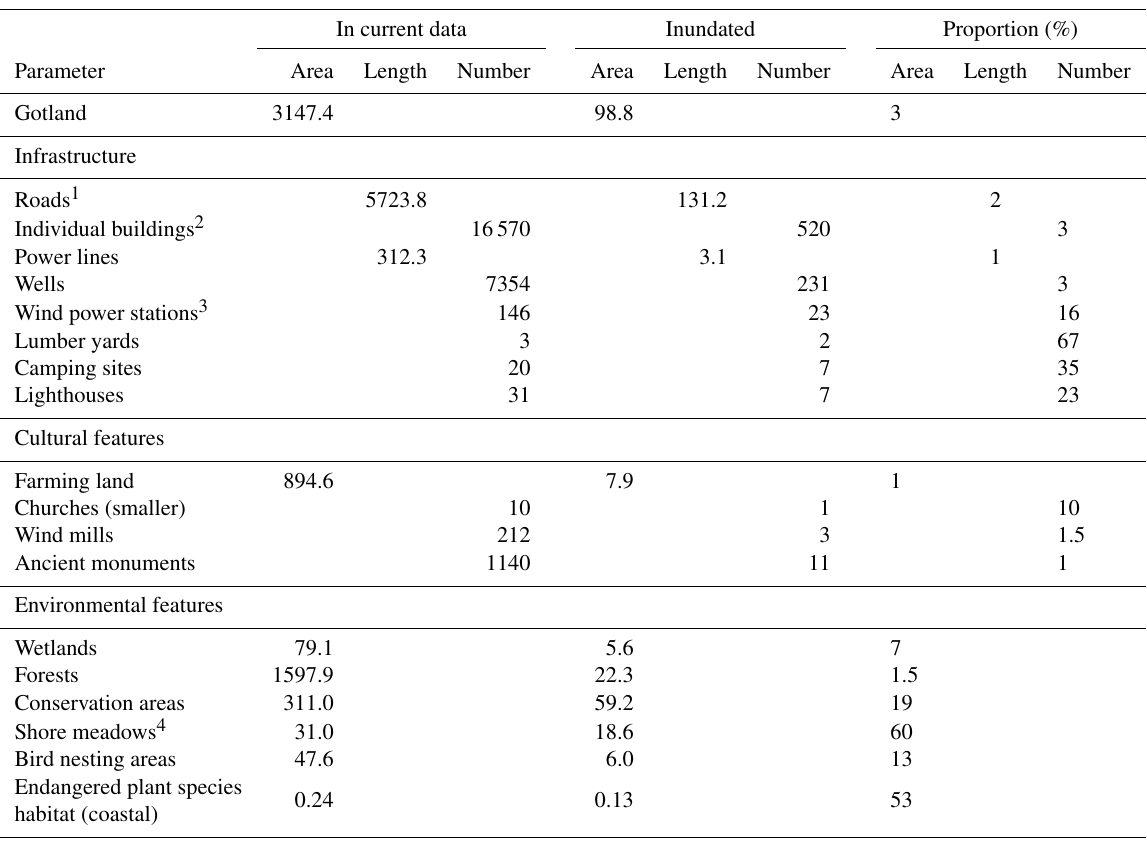
Table 2. Proportions of various types of infrastructure and features of cultural and environmental value that would be inundated in a 2m sea level rise scenario. Areas are given in square kilometres (km 2 ) and lengths in kilometres